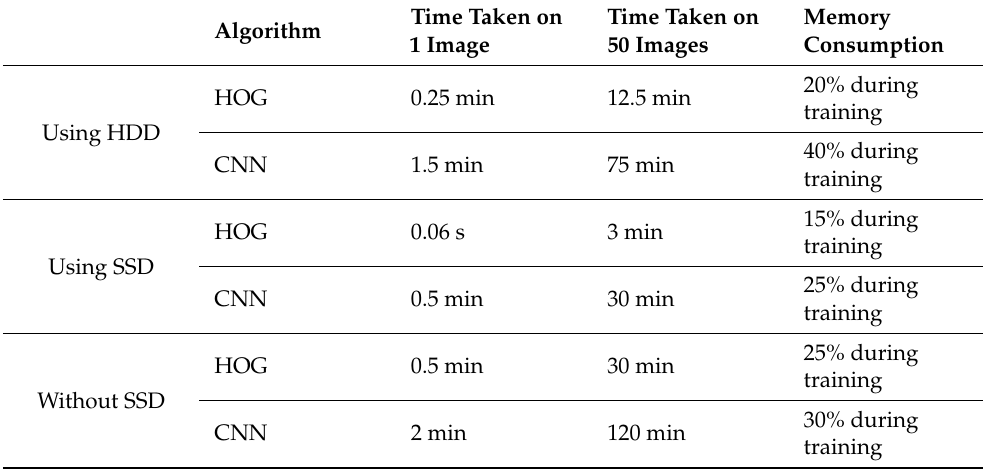
Table 4. Performance comparison of HOG and CNN using HDD and